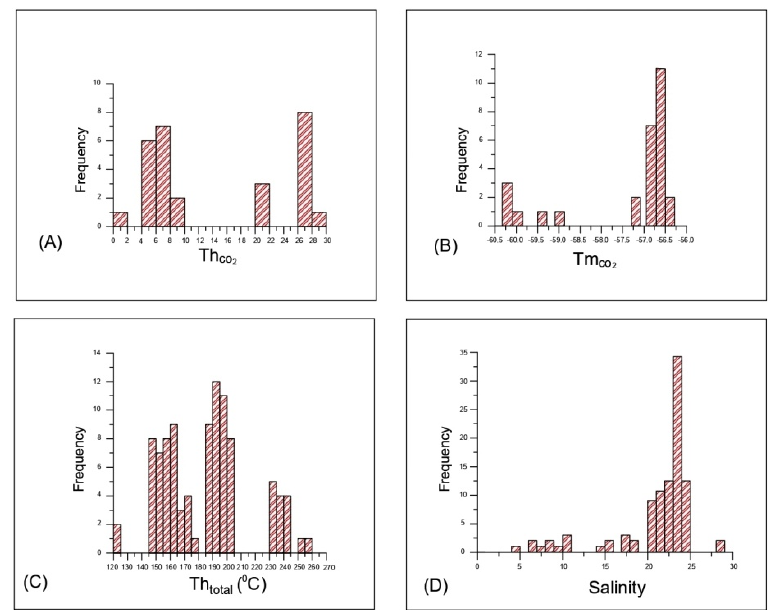
Figure 12. Histograms showing the relationship between: ( A ) Melting temperature of CO 2 (Tmco 2 ) vs. frequency; ( B ) Homogenization temperature of CO 2 (Thco 2 ) vs. frequency; ( C ) Homogenization temperature (Th total ) vs. Frequency; ( D ) Salinity (wt% NaCl equivalent) of the inclusion vs. frequency. Table 4. Fluid inclusion results of different inclusions from the Jagpura deposit.